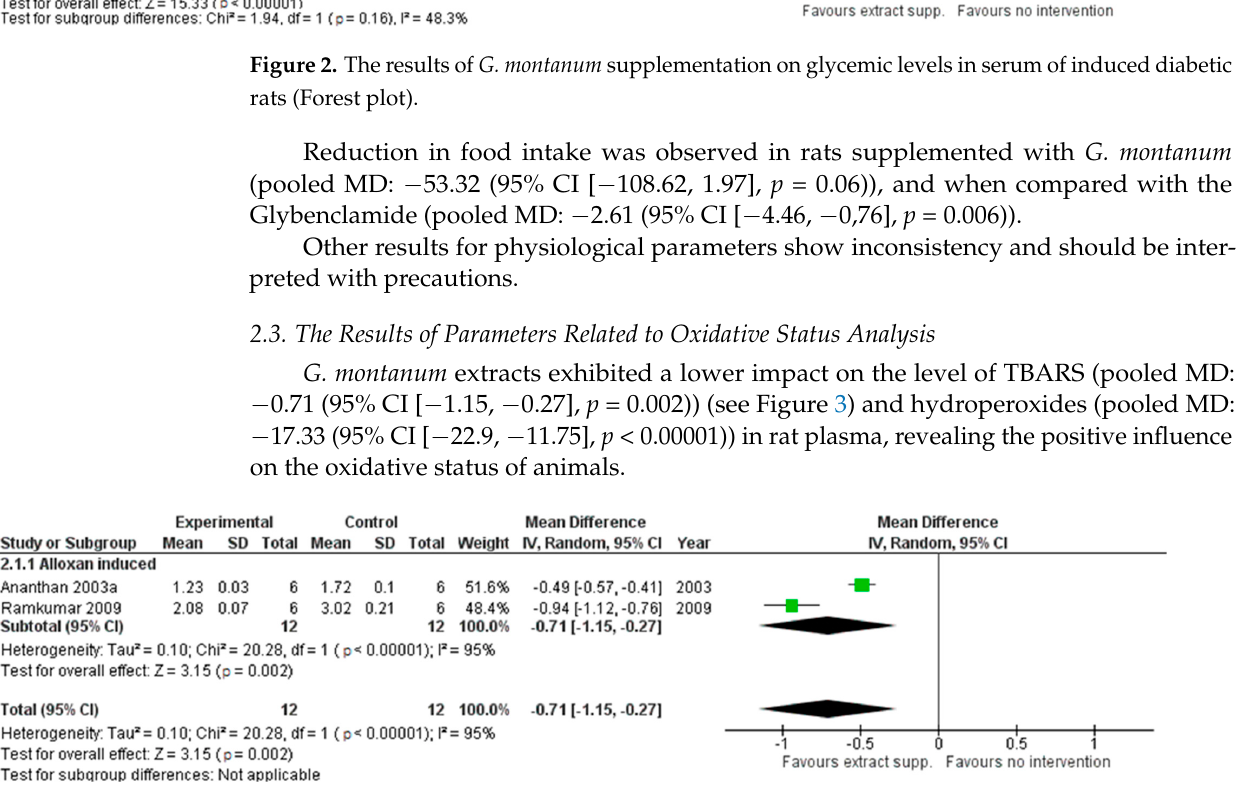
Figure 3. An animal model trial evaluated G. montanum supplementation on TBARS levels in serum of induced diabetic rats (Forest